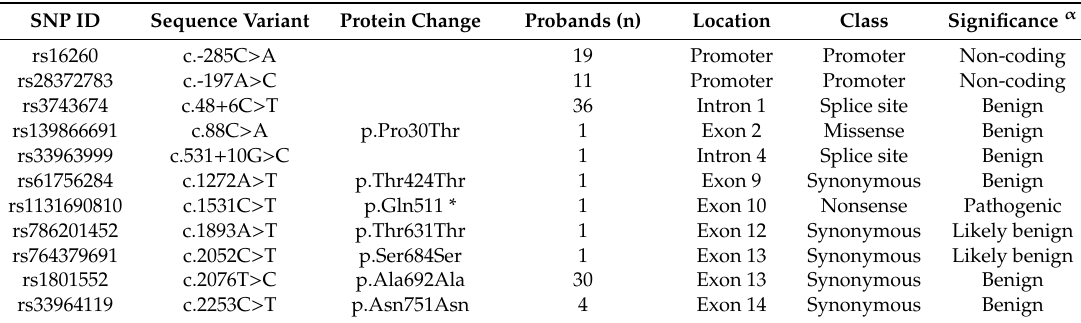
Table 2. CDH1 variants identified and pathologic significance.